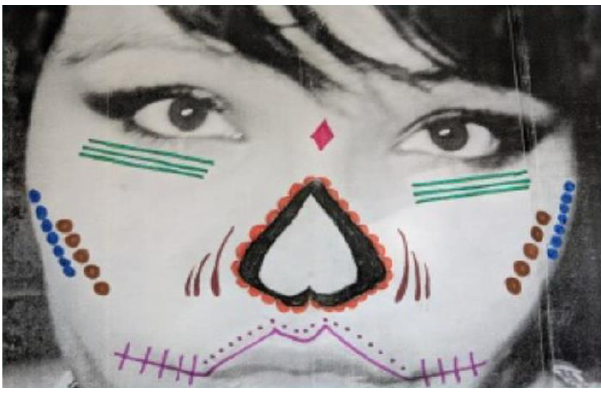
Figure 3: Photograph by MEY (2018: